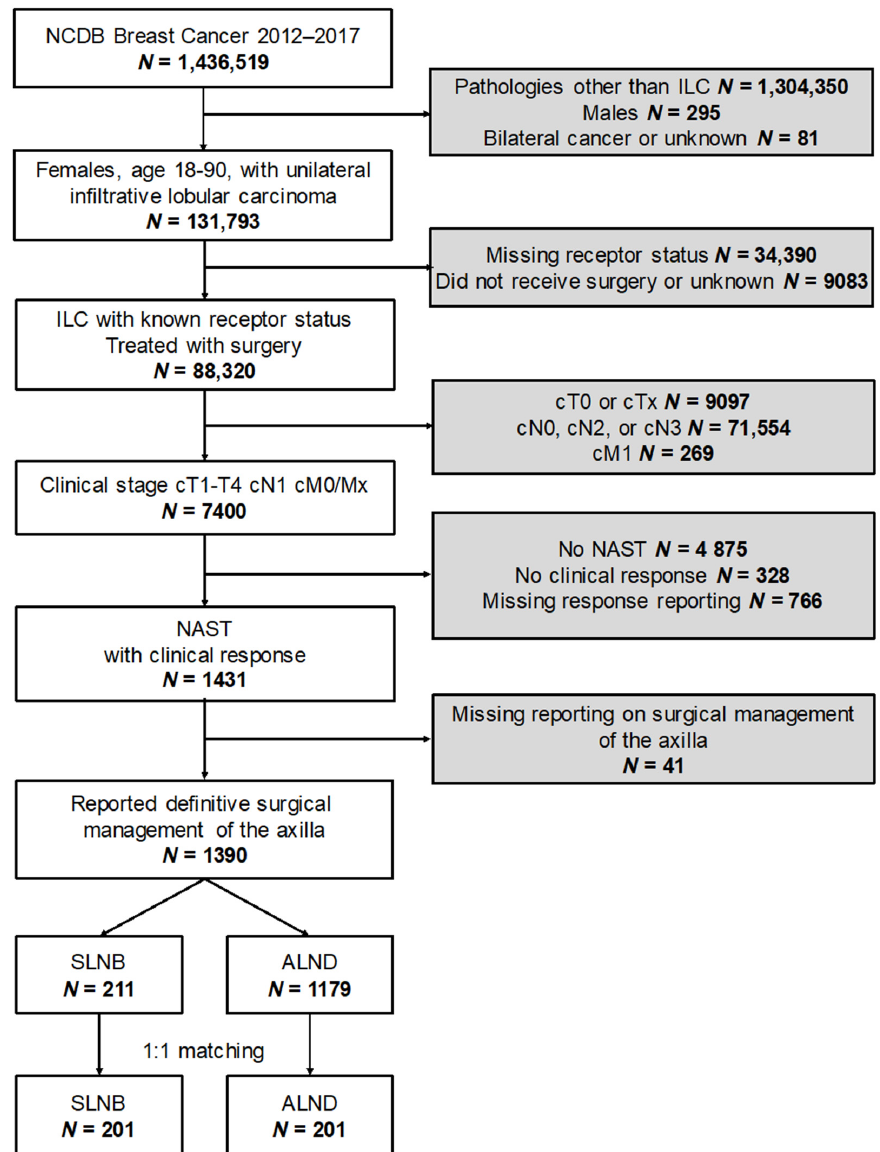
included. Figure 1 represents a flow diagram of the inclusion/exclusion criteria and the study design.